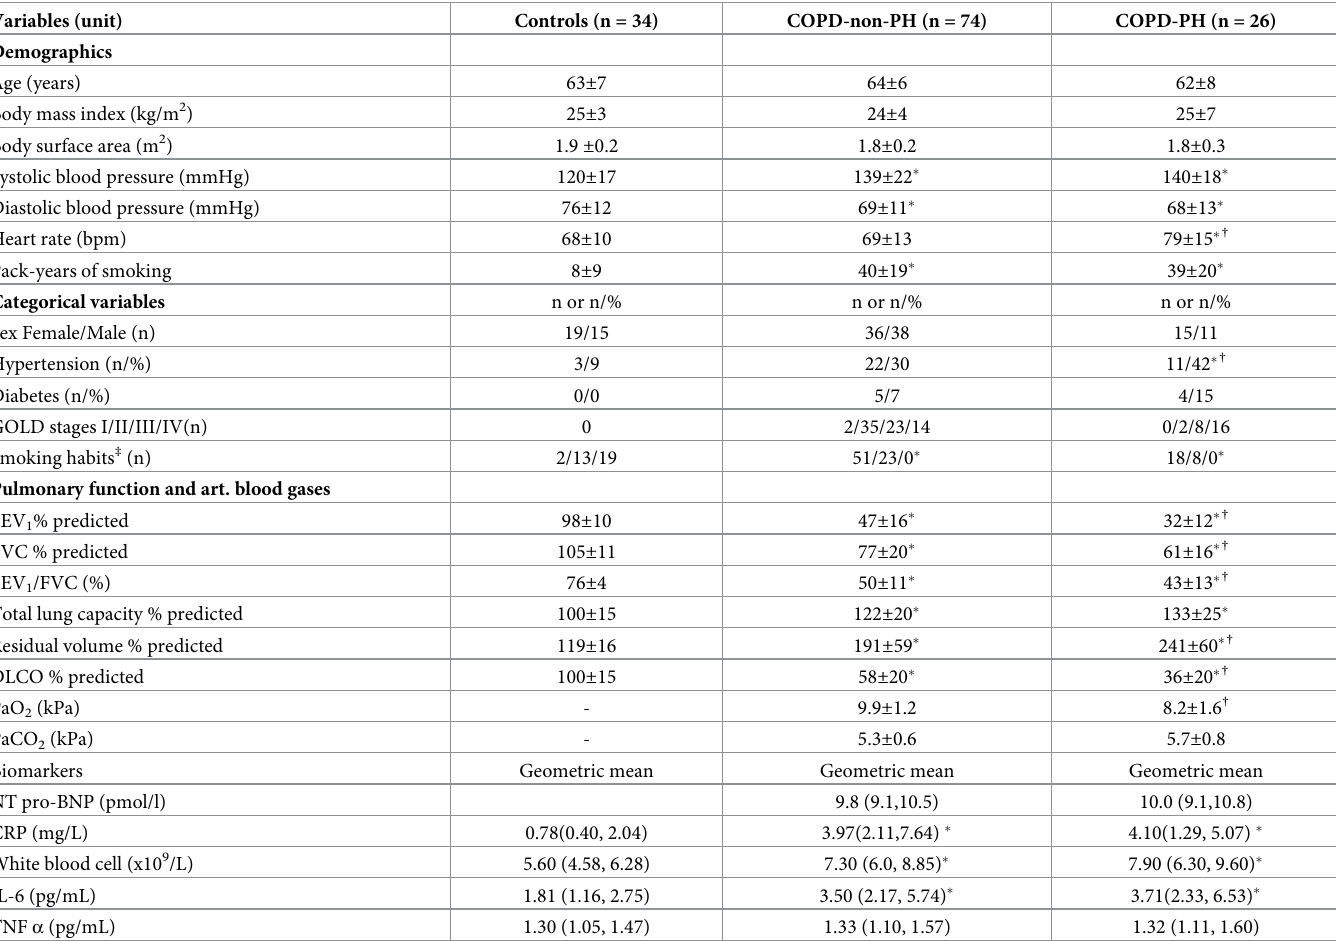
Table 1. Clinical characteristic of controls and patients with chronic obstructive pulmonary disease without (COPD-non-PH) and with pulmonary hypertension (COPD-PH).